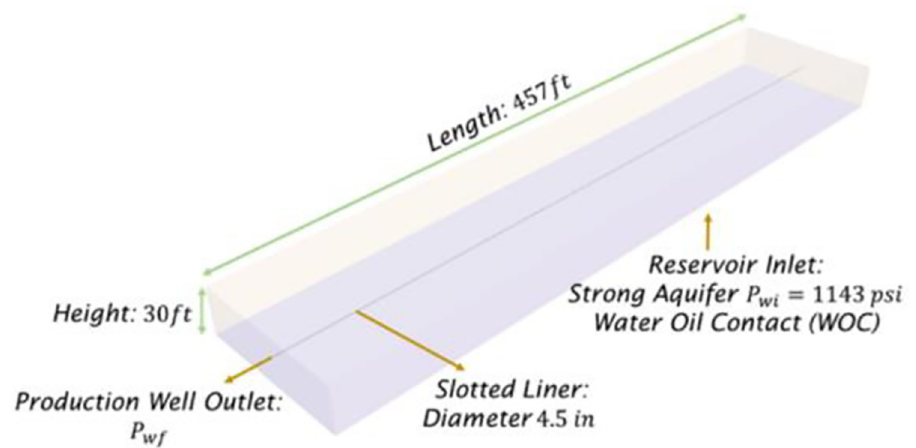
Fig 1. Domain geometry, initial, and boundary conditions used to conduct the numerical study.